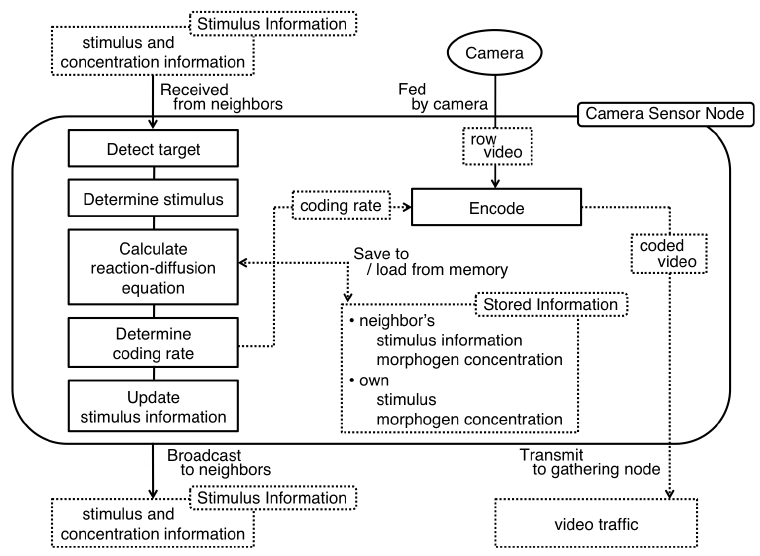
Figure 14 . Flow of information and data in a node.